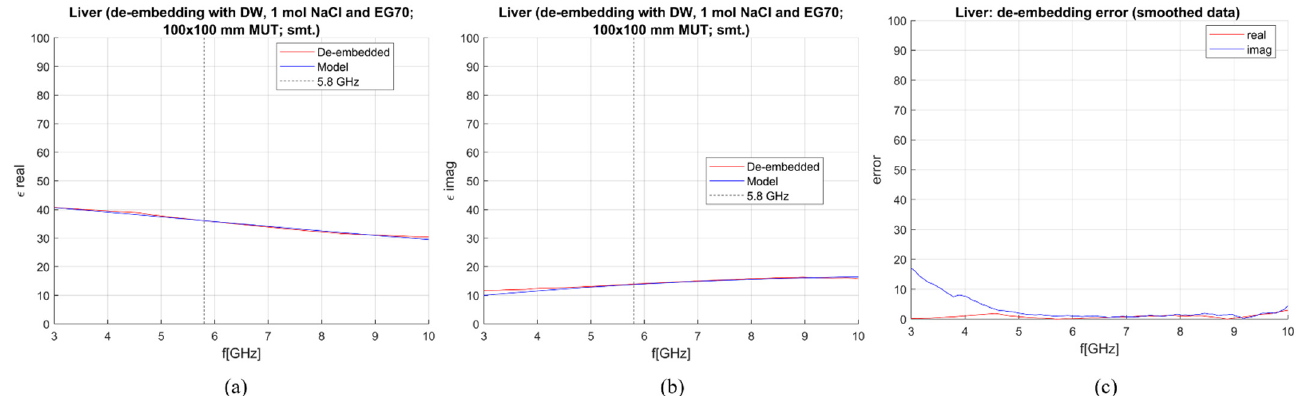
Figure 9. S&S de-embedding with the 3rd calibration option: DW, 0.1 mol and 2 mol NaCl (smooth- ing applied): ( a ) Calculated vs. reference ε ’; ( b ) calculated vs. reference ε ’’; ( c ) sensitivity (de-em- bedding error) for ε ’ (“real”) and ε ’’ (“imag”).